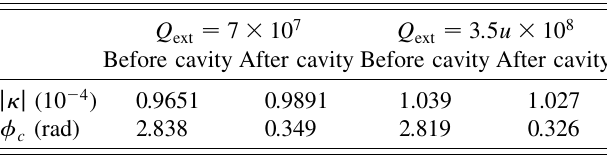
TABLE II. Coupler kick